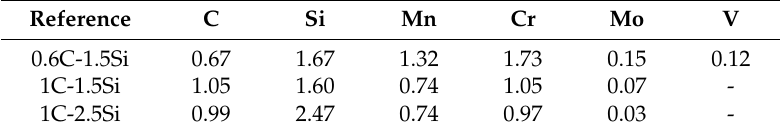
Table 2. Chemical composition (wt %) for the three steels used in the present investigation, as determined using optical emission spectrometry and combustion (LECO)